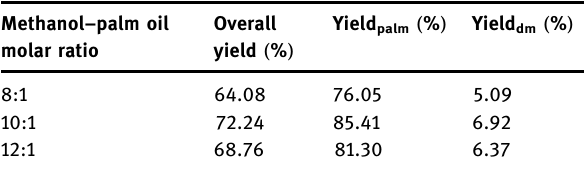
Table 5: Biodiesel yield for various palm oil – microalgae